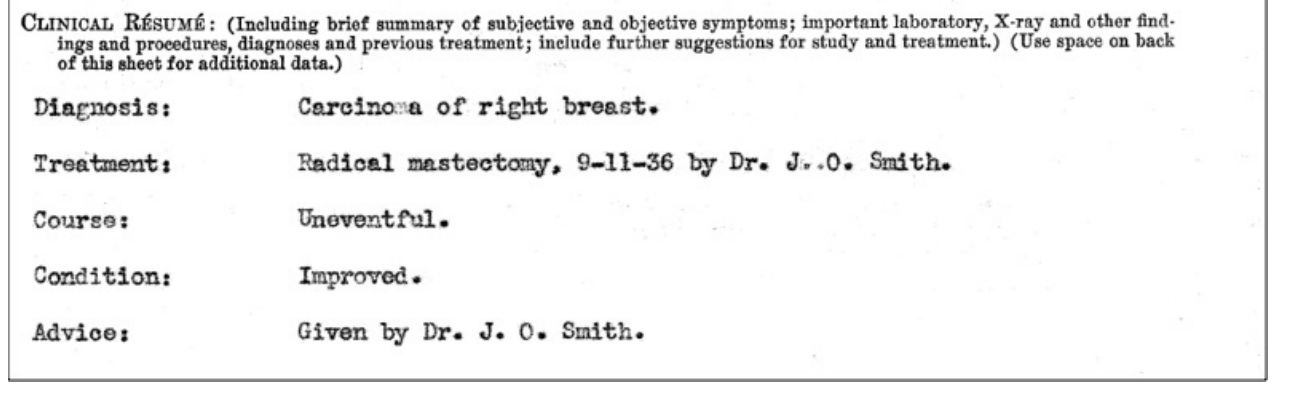
Figure 2 Breast cancer treatment description in a “Clinical